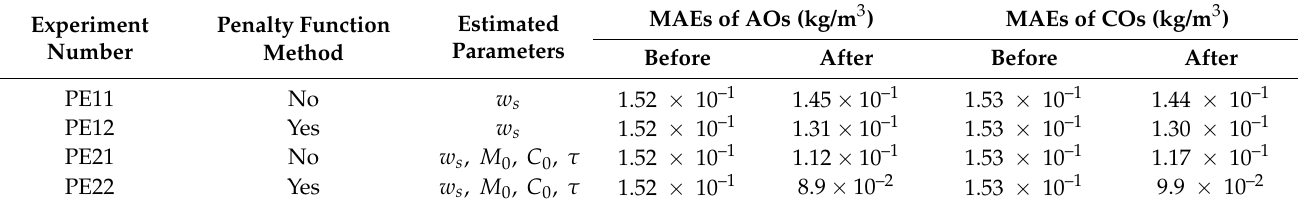
Table 3. Design and statistics of practical experiments.